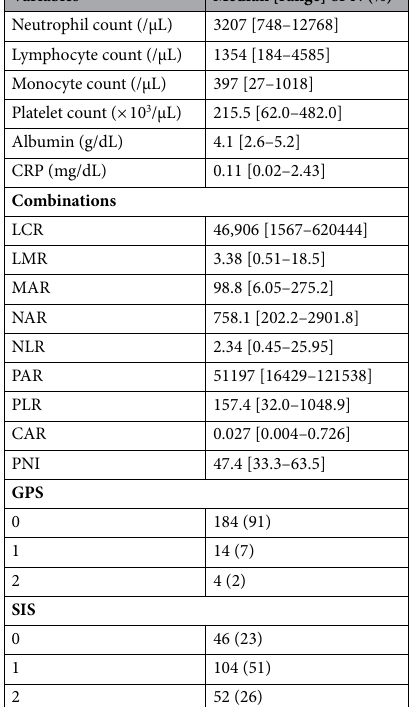
Table 2. Values of inflammation-related variables of study participants. CRP C-reactive protein, LCR lymphocyte count/C-reactive protein ratio, LMR lymphocyte count/monocyte count ratio, MAR monocyte count/albumin ratio, NAR neutrophil count /albumin ratio, NLR neutrophil count/lymphocyte count ratio, PAR platelet count /albumin ratio, PLR platelet count/lymphocyte count, CAR C-reactive protein/albumin ratio, PNI prognostic nutritional index, GPS Glasgow prognostic score, SIS systemic inflammation score.